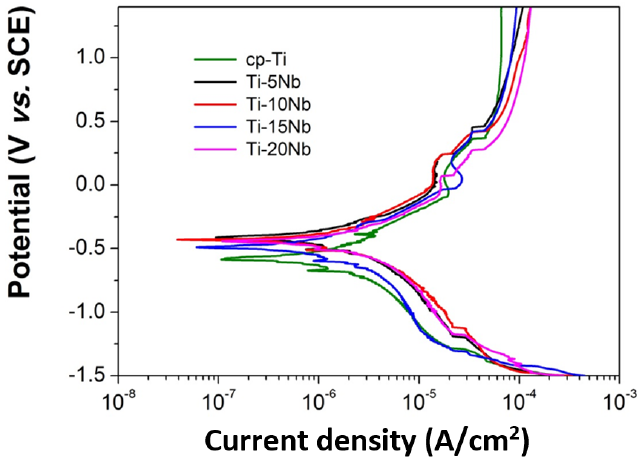
Figure 7. Representative potentiodynamic polarization curves of the cp-Ti and Ti-xNb alloys.